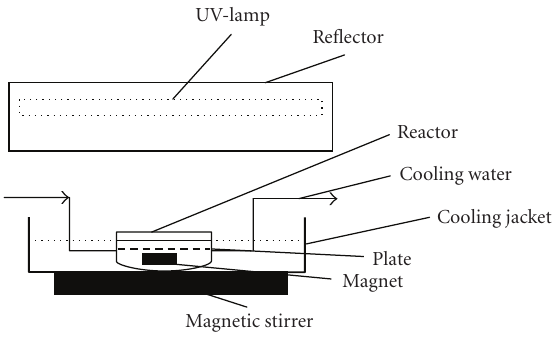
Figure 1: The photocatalytic oxidation experimental